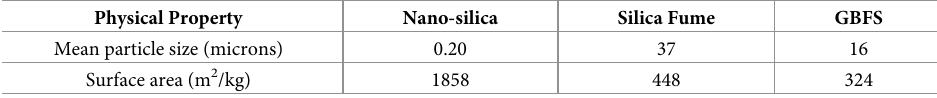
Table 1. Physical characteristics of nano-silica, silica fume, GBFS.